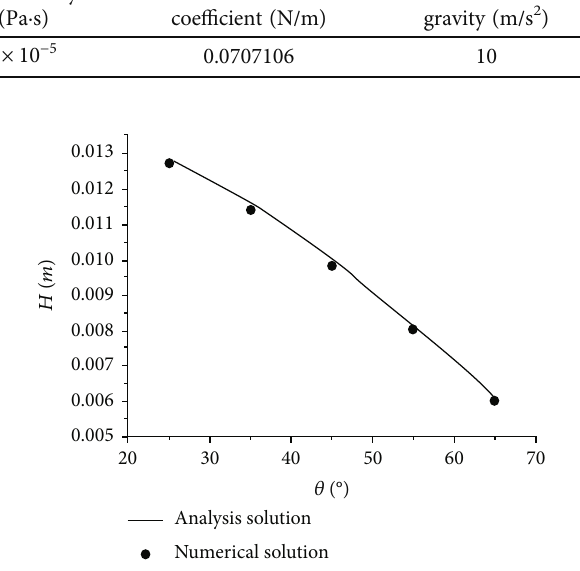
Figure 4: Liquid height in the capillary at di ff erent contact angle.